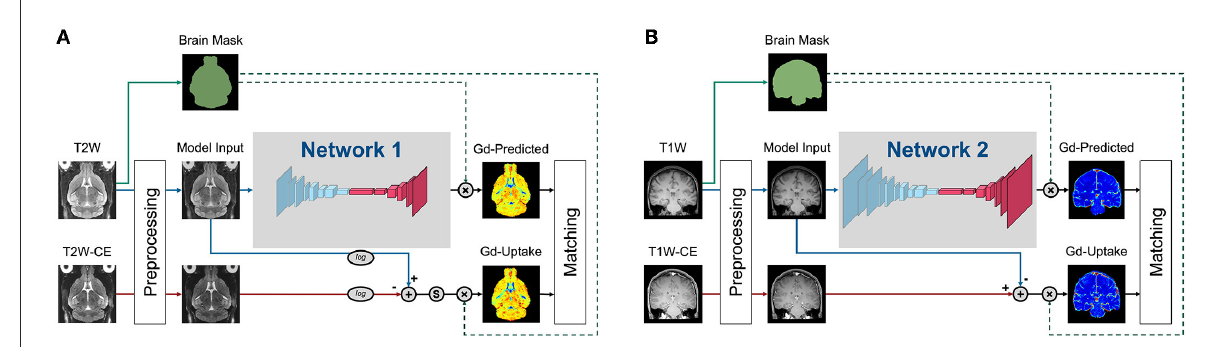
FIGURE2 Training strategies of the various DeepContrast models implemented. (A) This training strategy applied to the Healthy Mouse Model. Preprocessing includes intensity normalization and brain extraction. Ground truth Gd-Uptake was derived using the standardized delta-R2 equation. Note that there is an additional standardization step that maps the dynamic range of the standardized delta-R2 to the range of [0, 1], before the application of the brain mask. The loss function was calculated between the Gd-Uptake and the predicted version only using the voxels within the brain mask region. (B) This training strategy applied to the Healthy Human Model. Preprocessing included intensity normalization and brain extraction. Ground truth Gd-Uptake was derived using the steady-state delta-R1 equation. The loss function was calculated between the Gd-Uptake and the predicted version only using the voxels within the brain mask